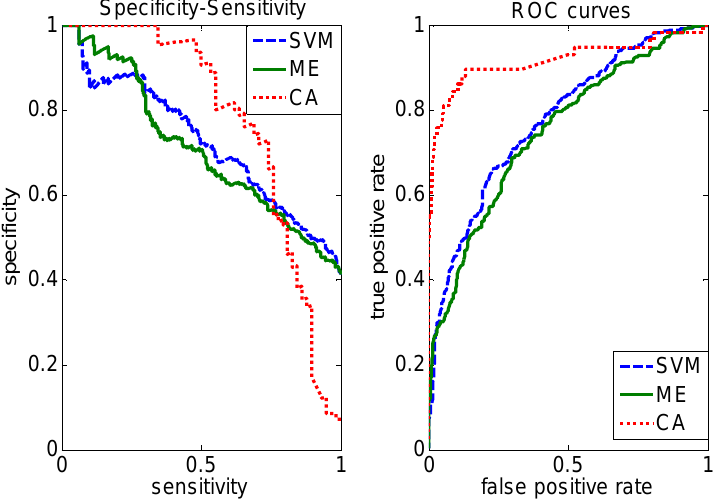
Figure 3. Specificity-sensitivity and ROC curves on the Complete data based on SVM, ME and